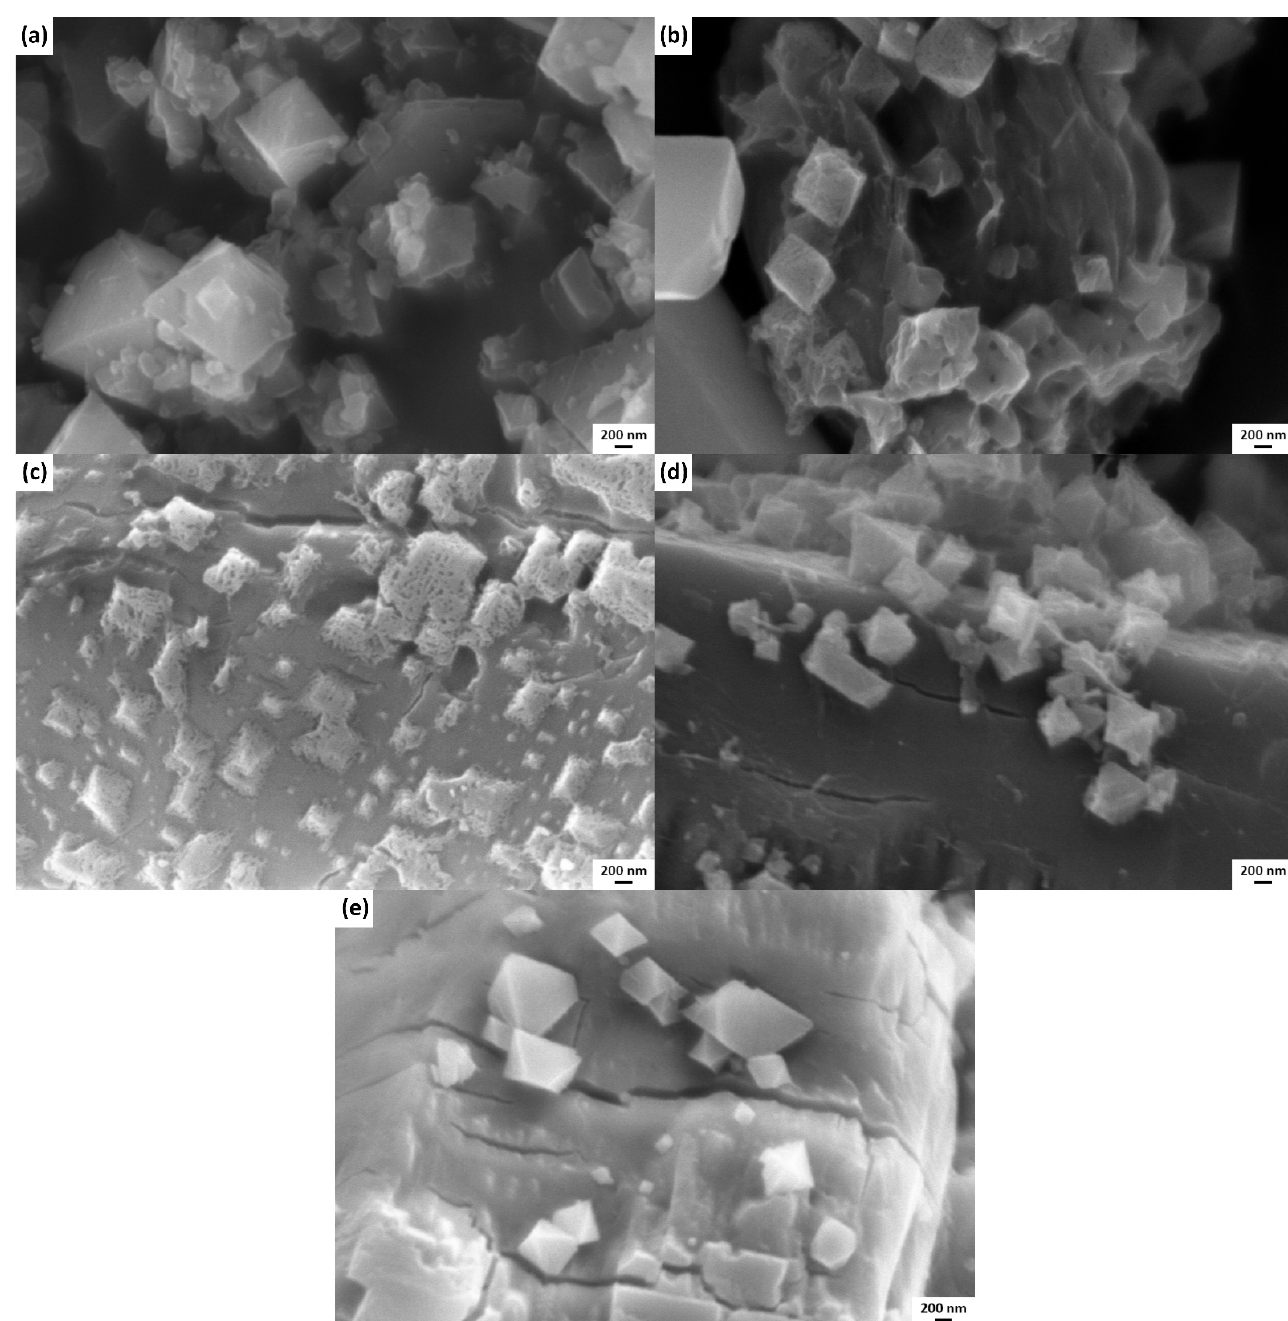
Figure 1. SEM images of ( a ) HKUST-1 and CNCs@HKUST-1 composites with the addition of CNCs of ( b ) 2.5%, ( c ) 5%, ( d ) 7.5%, and ( e ) 10%.